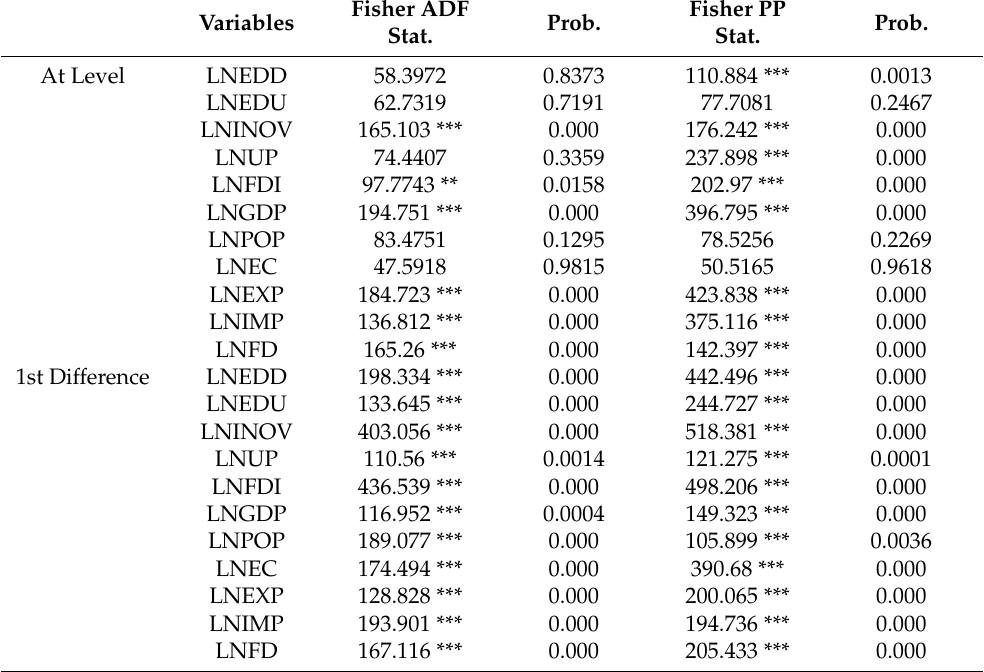
Table 2. Unit Root Test.